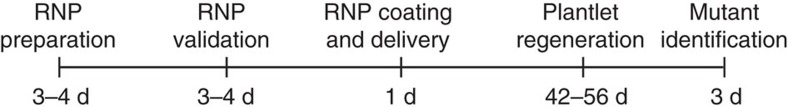
Flowchart of CRISPR/Cas9 RNP induced targeted mutagenesis in wheat.RNP preparation takes 3–4 days (including Cas9 protein purification). RNP validation in vitro and in protoplasts takes 3–4 days (not including the time for plant preparation). RNP coating and delivery can be completed within 4 h. After this, the plantlets regenerate in 6–8 weeks. Identification of mutants by PCR-RE and DNA sequencing takes 3 days.